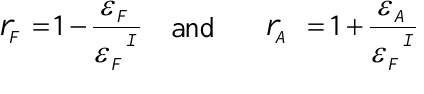
= 2.43% ± 0.30%). E = fixity; EF: heating to T F